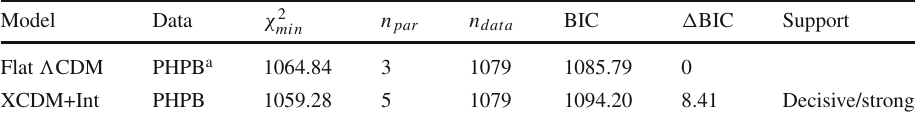
Table 5 BIC comparison